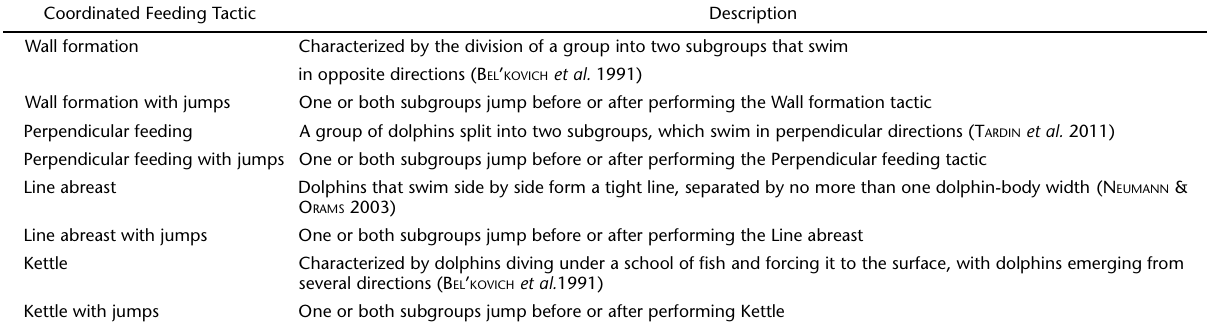
Table I. Description of the eight categories of feeding tactics. Coordinated Feeding Tactic